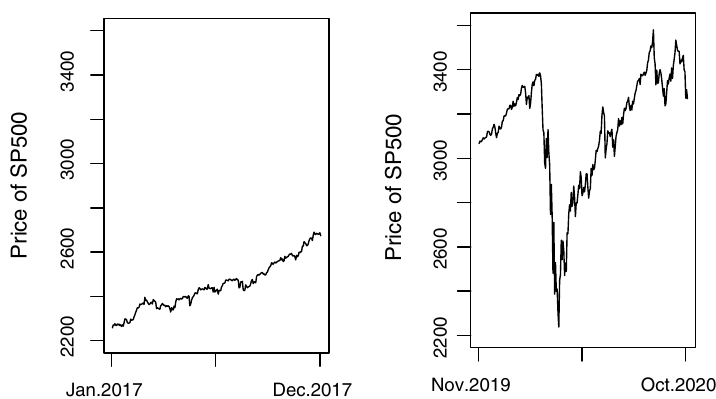
Fig. 1 The left subfigure depicts the price of S &P500 from January 2017 to December 2017 which presents a slow growth; The right subfigure depicts the price of S &P500 from November 2019 to October